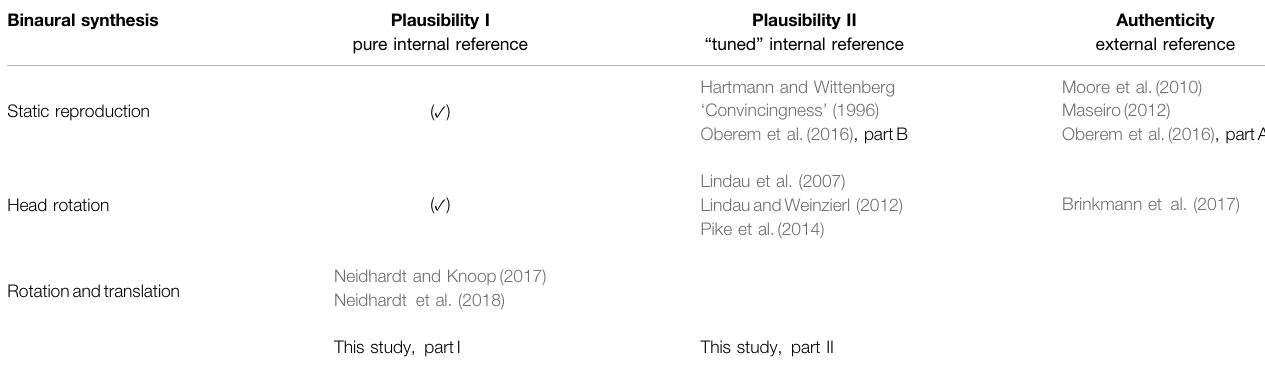
TABLE 1 | Summary of previous studies investigating plausibility and authenticity of binaural synthesis. Plausibility is split up into the two proposed categories of measuring the agreement with the pure internal reference or a tuned internal reference as a result of the indirect comparison with the real counterpart of the scene. This overview is not exhaustive but provides examples for each of the